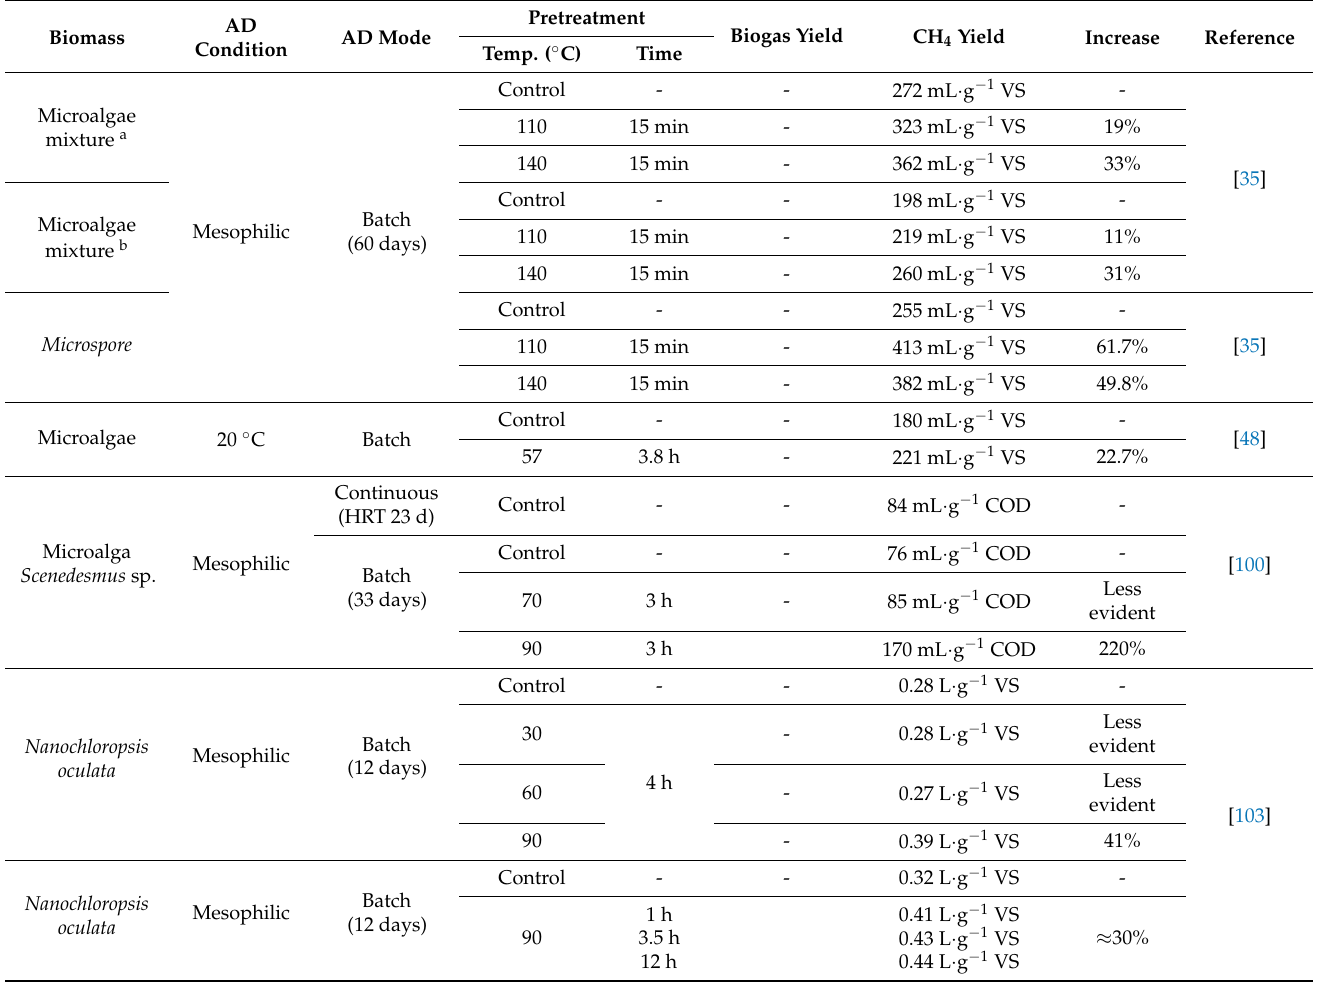
Table 5. Biogas production variation of algae biomass after LTPT (Temp. ≤